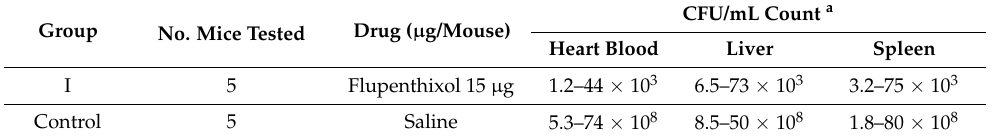
Table 6. Reduction in colony-forming units (CFUs) of Salmonella typhimurium NCTC 74 at 18 h following treatment with flupenthixol in heart blood and organ homogenates of